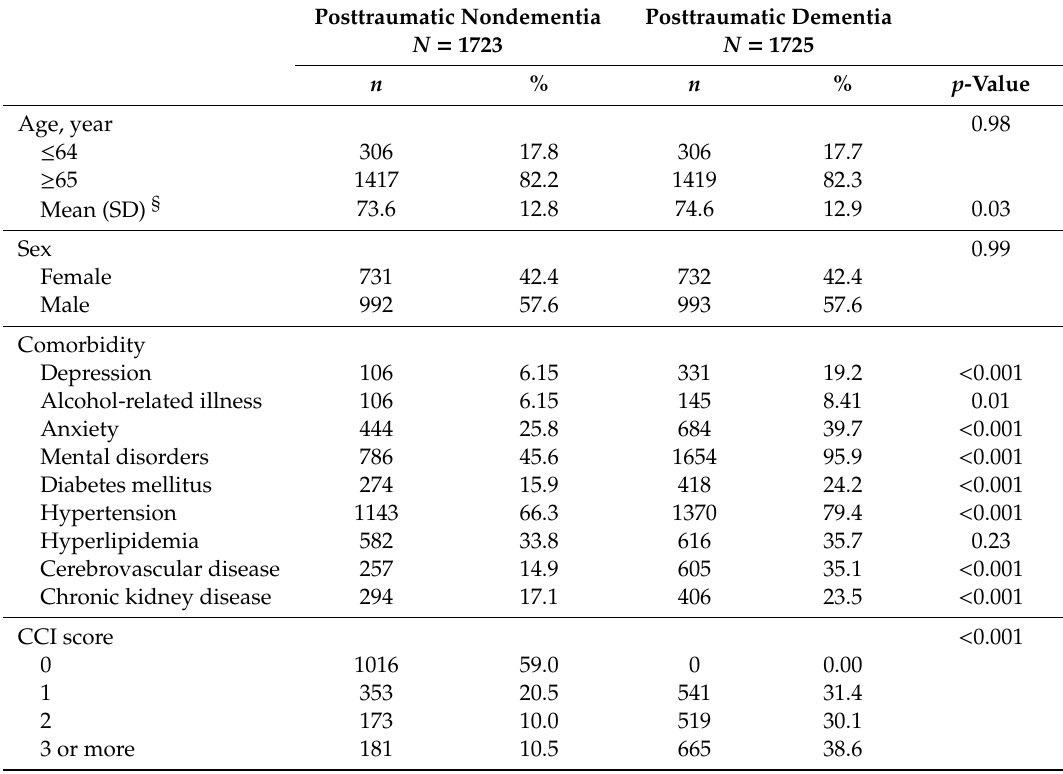
Table 1. Distribution of age, sex, and comorbidity in the posttraumatic dementia and posttraumatic nondementia cohorts.